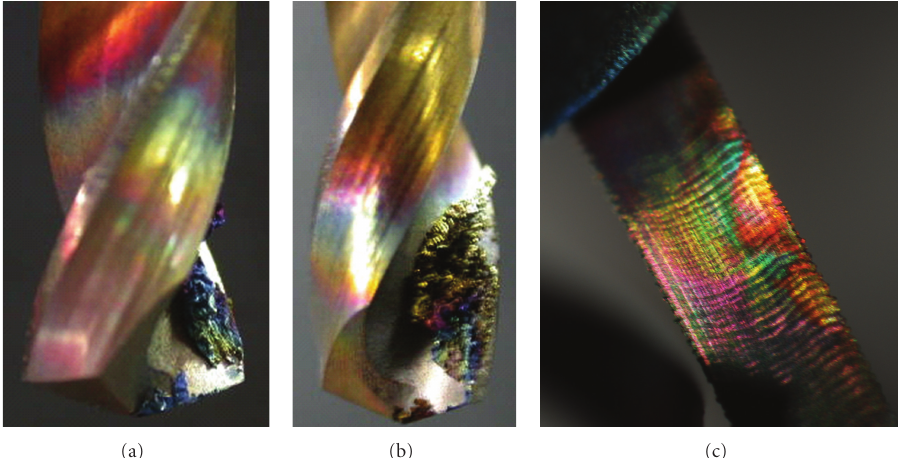
Figure 5: Aspect of the drilling tool after (a) sixteen and (b) seventeen holes at 30m/min. (c) Chips collected after dry machining of Ti-6Al- 4V